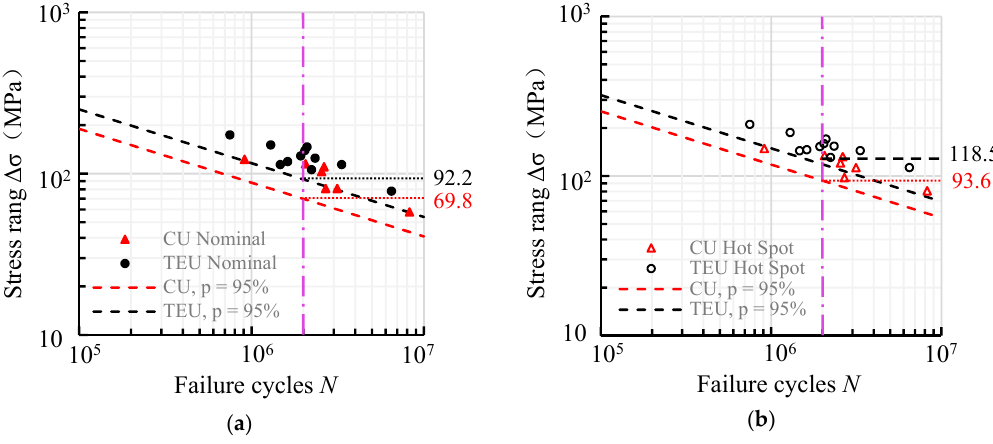
Figure 9. P–S–N curve under the survival rate of 95%: ( a ) nominal stress and ( b ) hot spot stress.